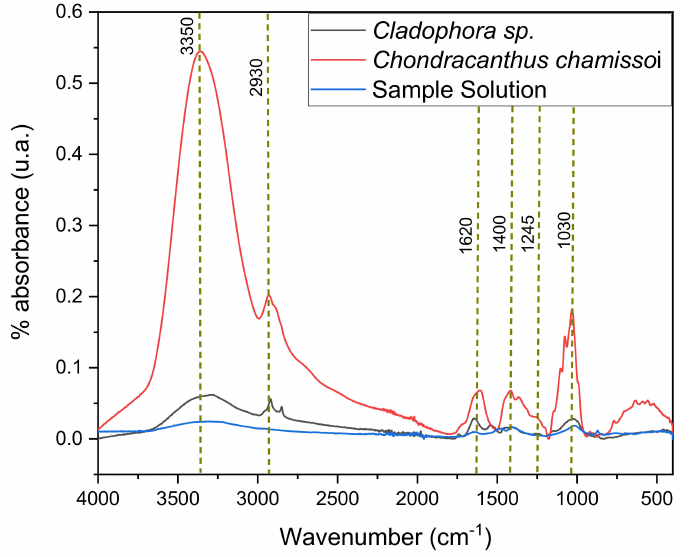
Figure 4. FTIR spectrophotometry of the solution of As and algae used in the biosorption process.